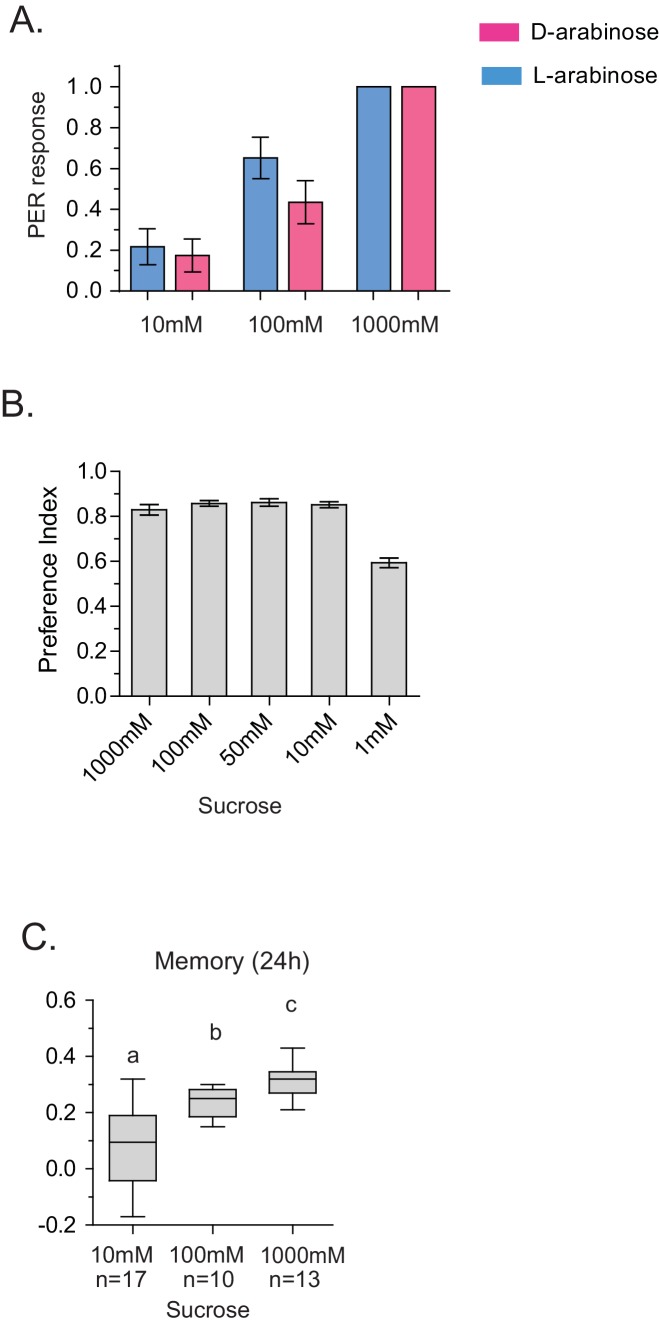
Detection and memory.(A) Proboscis extension reflex response to D- and L-arabinose. Flies were given a drop of water, then 10 mM D-ara, then 100 mM D-ara, then 1 M D-ara, water, followed by 10 mM L-ara, 100 mM L-ara, and 1 M L-ara. Alternate flies were given D-ara or L-ara first. (n = 26 for each concentration). (B) Flies only begin to have trouble detecting sucrose in the two-choice test (paired with water) when sucrose is ≤1 mM. (C) Flies form better memories with increasing concentrations of sucrose. 10 mM sucrose (the maximum possible contamination given L-arabinose purity of ≥99%) does not produce robust long-term memory. For multiple samples, one-way ANOVA with Tukey’s multiple comparisons test was performed, and significant differences (p<0.05) are denoted by different letters. Results with error bars are means ± s.e.m. ns, not significant. *≤0.01, **≤0.001 and ***≤0.0001.